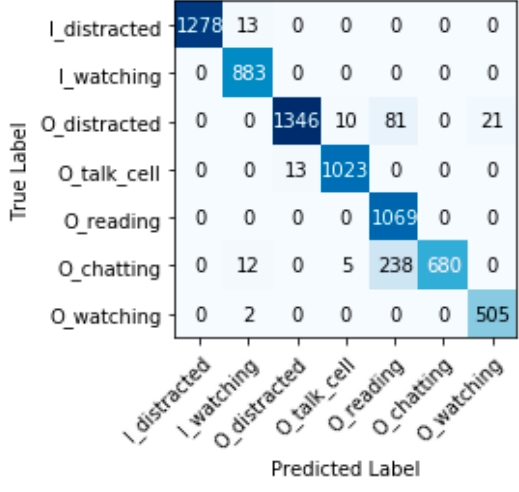
Figure 12. Confusion matrix VGG-19.